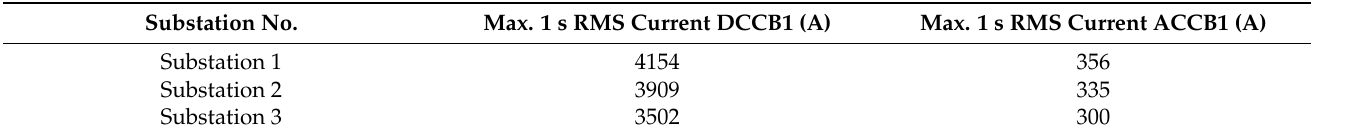
Table 13. TRU CB simulation